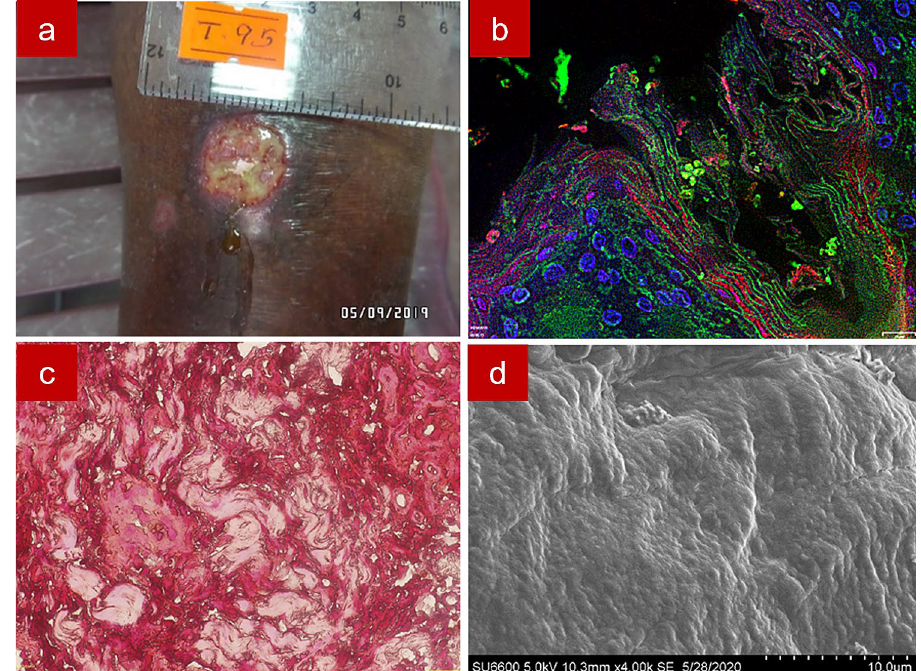
Figure 8. Sample 27. Image of a wet ulcer of 8 weeks duration in the lower limb with green colour pus discharge ( a ); Fluorescence in situ hybridization showing bacteria in red with the CY3 tagged Eu bacterial probe, extracellular polymeric substances in green with Concavalin A conjugated Alexa Fluor 488 and tissue nuclei in blue with DAPI ( b ); Gram staining showing gram-negative rods ( c ); Scanning electron microscopy showing bacteria in embedded in smooth extracellular polymeric substance ( d